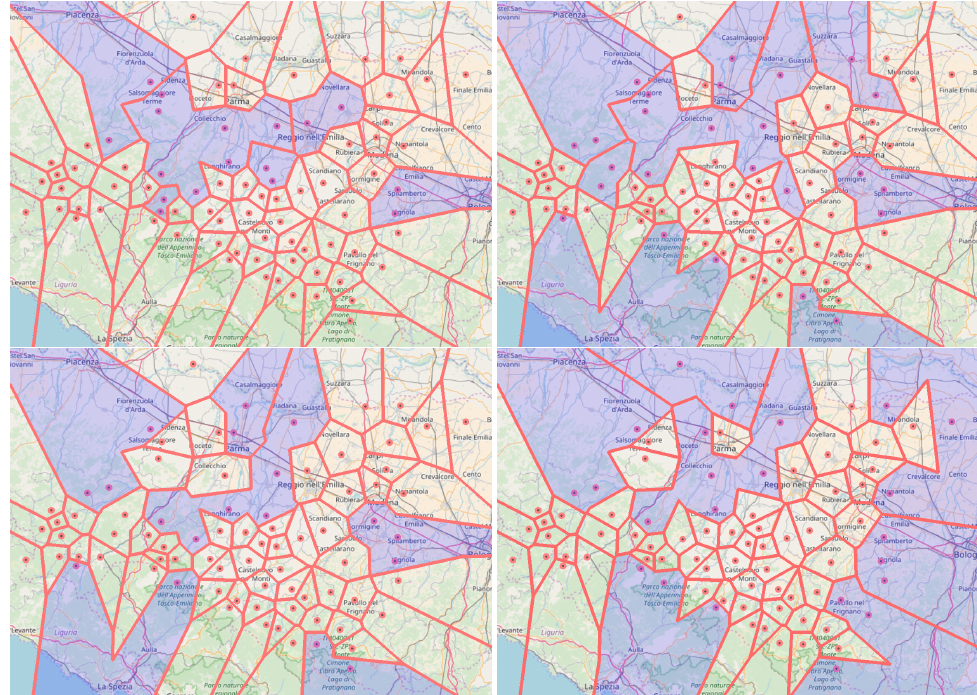
Figure 3. Merged Voronoi regions (in blue) obtained during four different